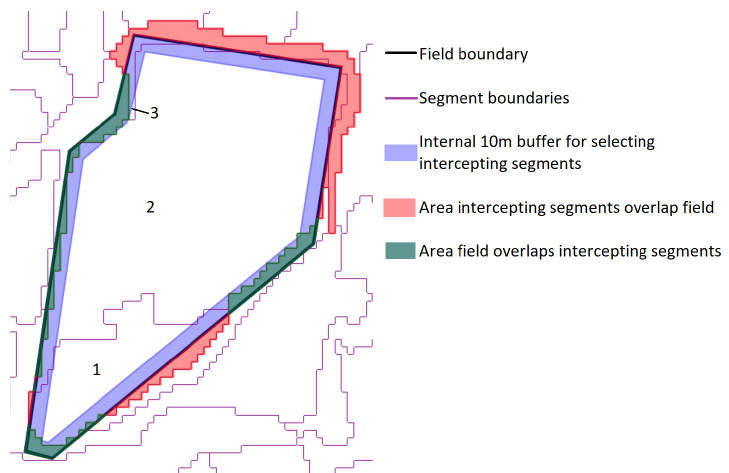
Figure 4. Assessment of generated segments against a polygon outlining one of the 75 test fields. In this example, the total area error is the sum of the area of the red and green shapes, and there are three segments intercepting the polygon outlining the